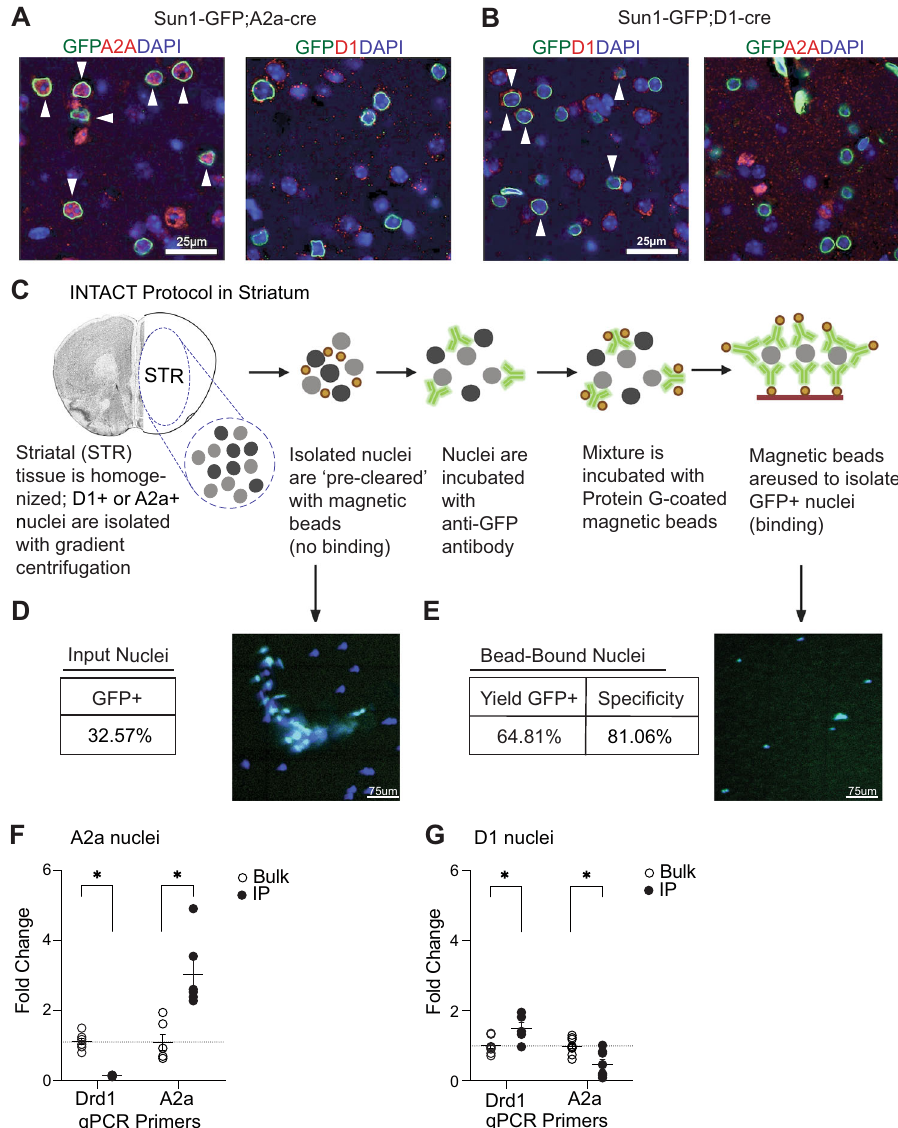
Fig. 1 | SUN1-GFP facilitates isolation of D1 or A2a neurons in the striatum. A Immunohistochemistry displaying DAPI/GFP/A2a (left) and D1 (right) from the striatum of SUN1-GFP;A2a-CRE+animals. n =3/group. Arrows indicate co- localization of all three markers. B Immunohistochemistry displaying DAPI/GFP/ Drd1 (left) and A2a (right) from the striatum of SUN1-GFP; D1-CRE+animals. n =3/ group.Arrowsindicateco-localizationofallthreemarkers.Theseexperimentswere replicated 3 times with similar results. C INTACT schematic created at Bior- ender.com. D Total(%)ofCre+cellsinstriatum.Imagedepictstotalnucleiisolation ( n =2/cell type and antibody) E Yield (%) and speci fi city (%) of GFP+nuclei. Image